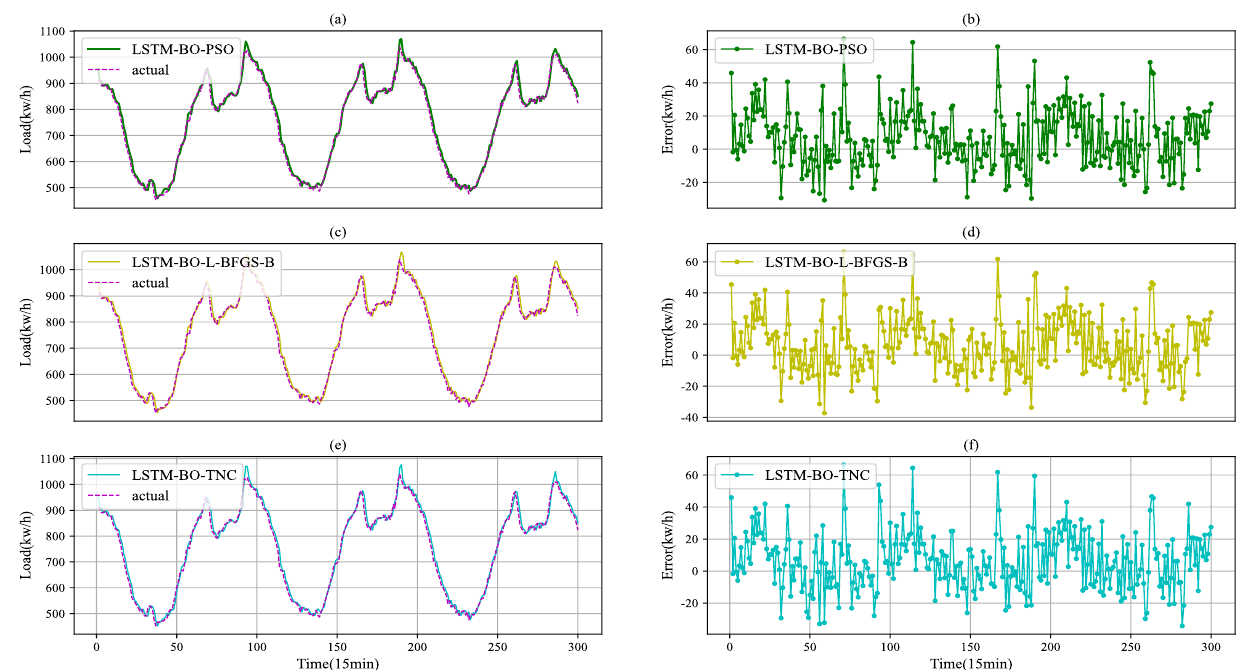
Figure 7. Load prediction for LSTM. ( a , c , e ) The load fitting curves for LSTM. ( b , d , f ) The load prediction error curves for LSTM, which are obtained by subtracting the measured values from the predicted values. And the error curves correspond to the left fitting curves respectively.